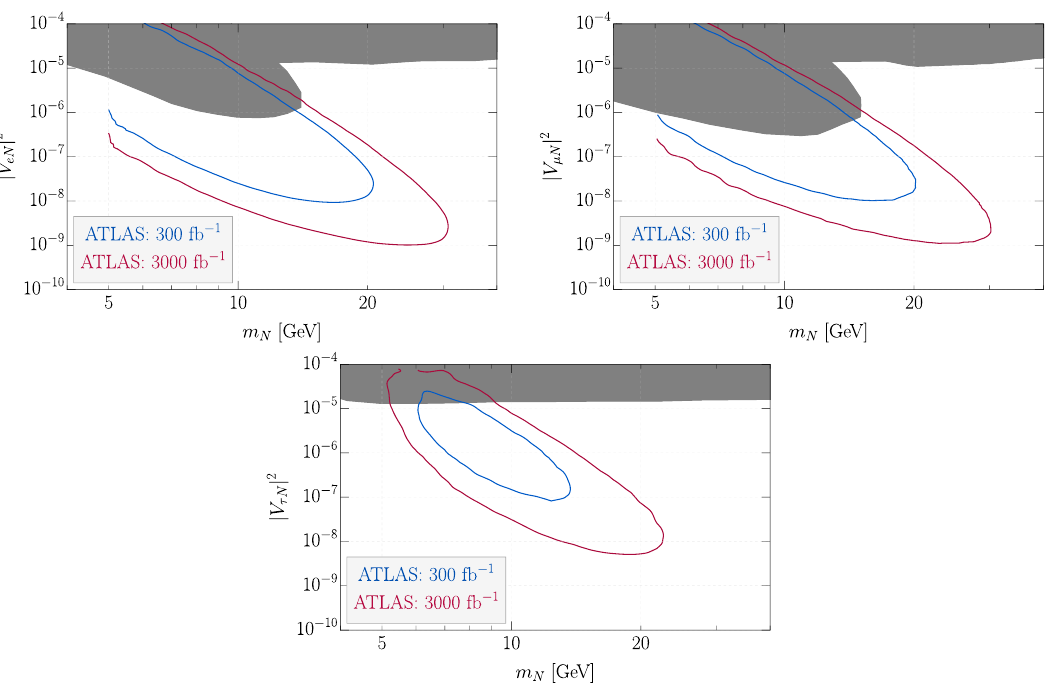
Figure 1 . Minimal scenario sensitivity reach on | V lN | 2 as a function of m N , for l = e, µ, τ . The dark region corresponds to current experimental limits obtained at several experiments: ATLAS [66], CMS [67, 68], DELPHI [69], and LHCb [70,